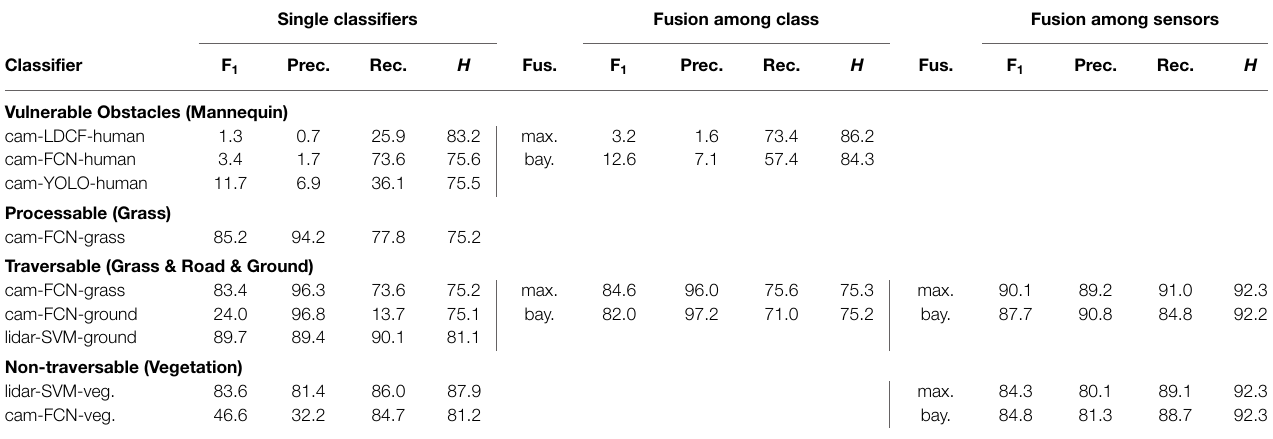
TABLE 2 | Evaluation of static obstacle detection and mapping.